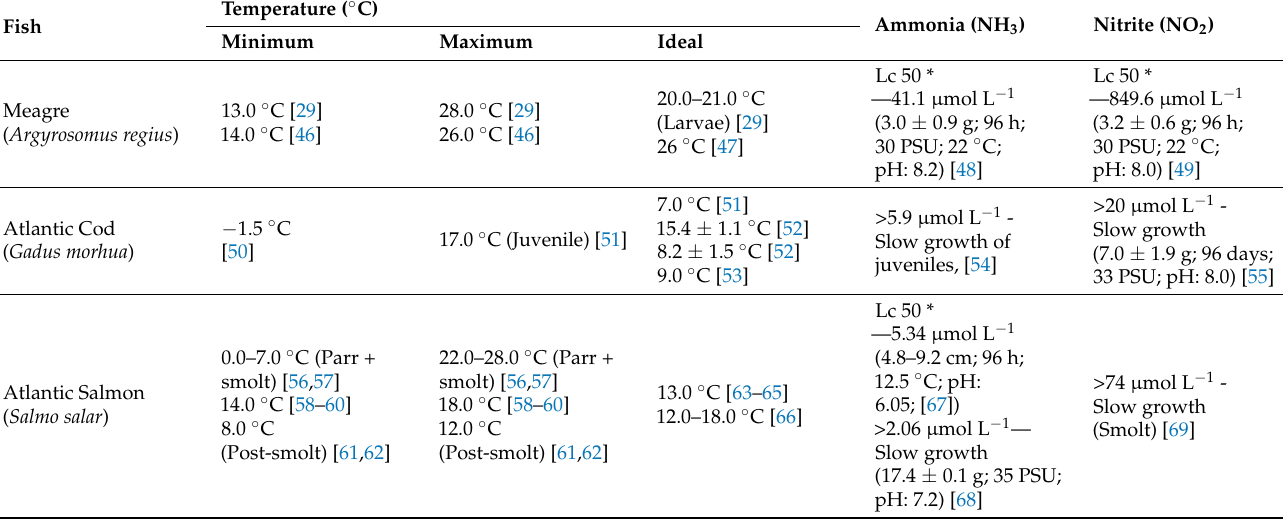
Table 3. Minimum, maximum, and optimal temperature ( ◦ C) and limits of ammonia ( µ mol L − 1 ) and nitrite ( µ mol L − 1 ) tolerated by the selected